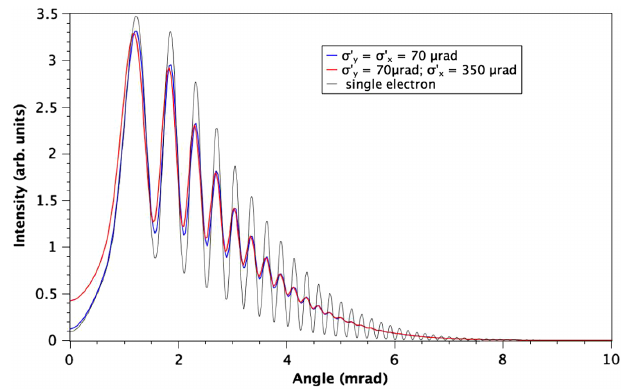
FIG. 14. Vertical scan of OSRI from dipoles 2,3 for various values of horizontal ( x ) and vertical ( y ) divergences along with single electron scan ( E ¼ 286